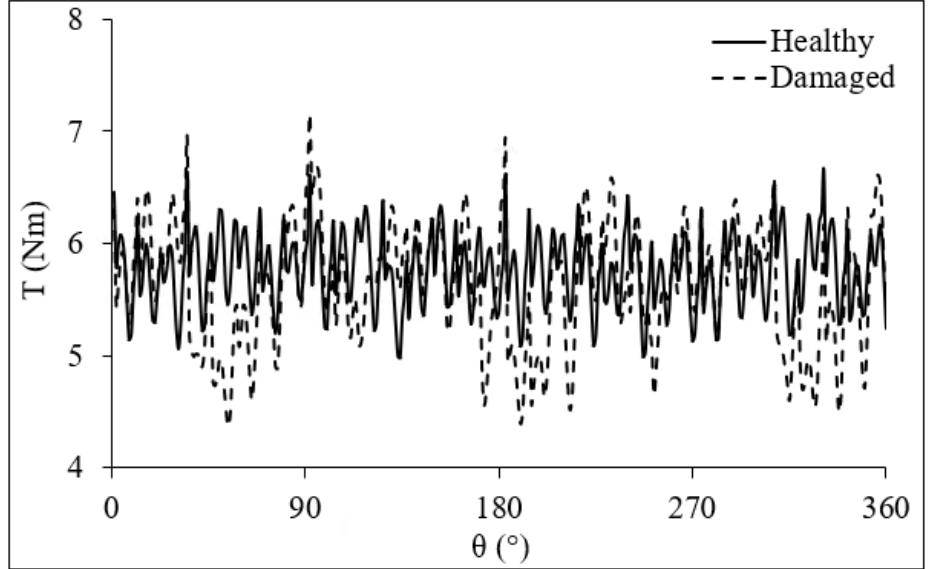
Figure 6. Torque signals for one complete revolution of healthy and damaged VAWTs. Table 1. Torque characteristics of healthy and damaged VAWTs. Torque